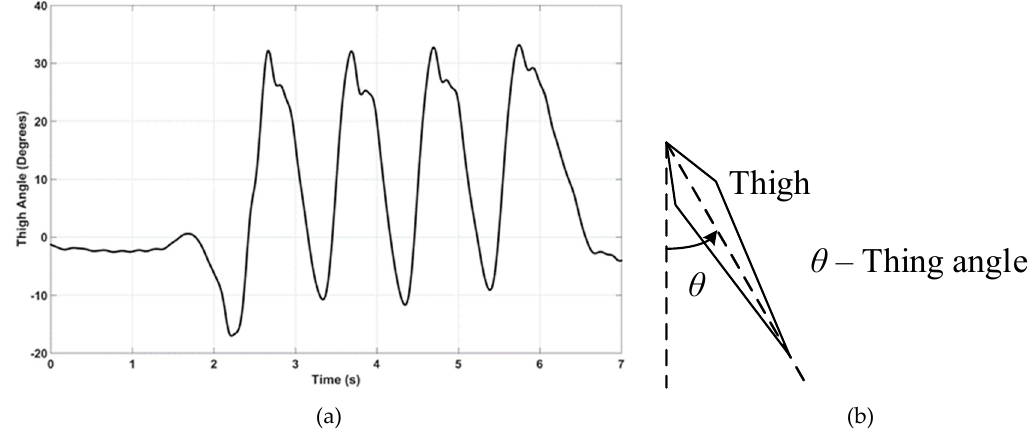
Figure 1. ( a ) Thigh angle of a subject during a single trial measured from the motion analysis lab (MAL). ( b ) Thigh angle measuring